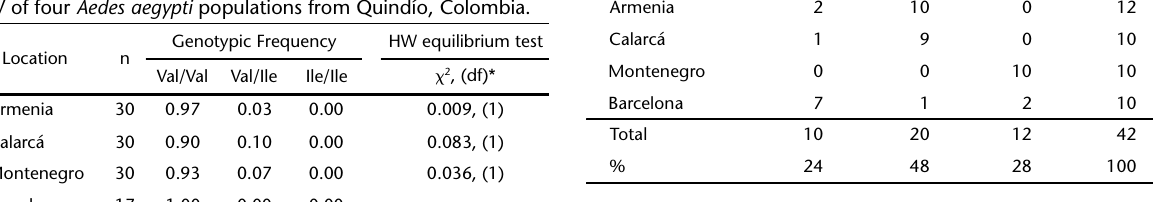
of four A. aegypti populations from Colombia. v